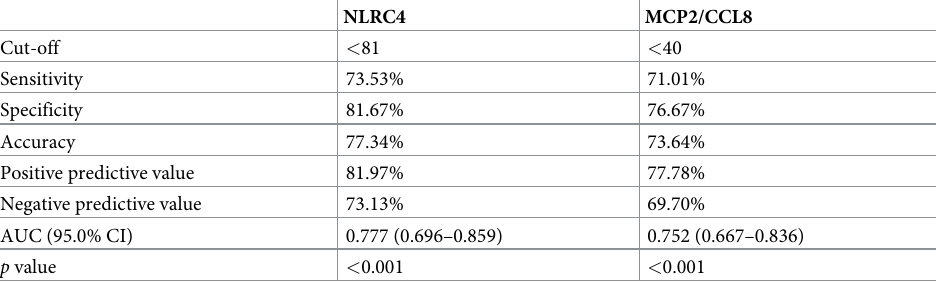
Table 4. Measurements of performance to determine active Crohn’s disease.